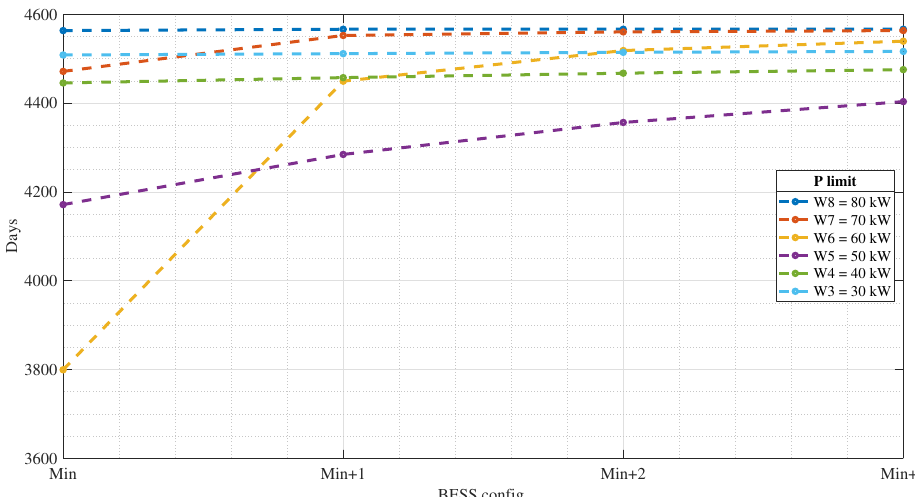
Figure 12. Days until ∇ Q = 20% as a function of the BESS configuration in